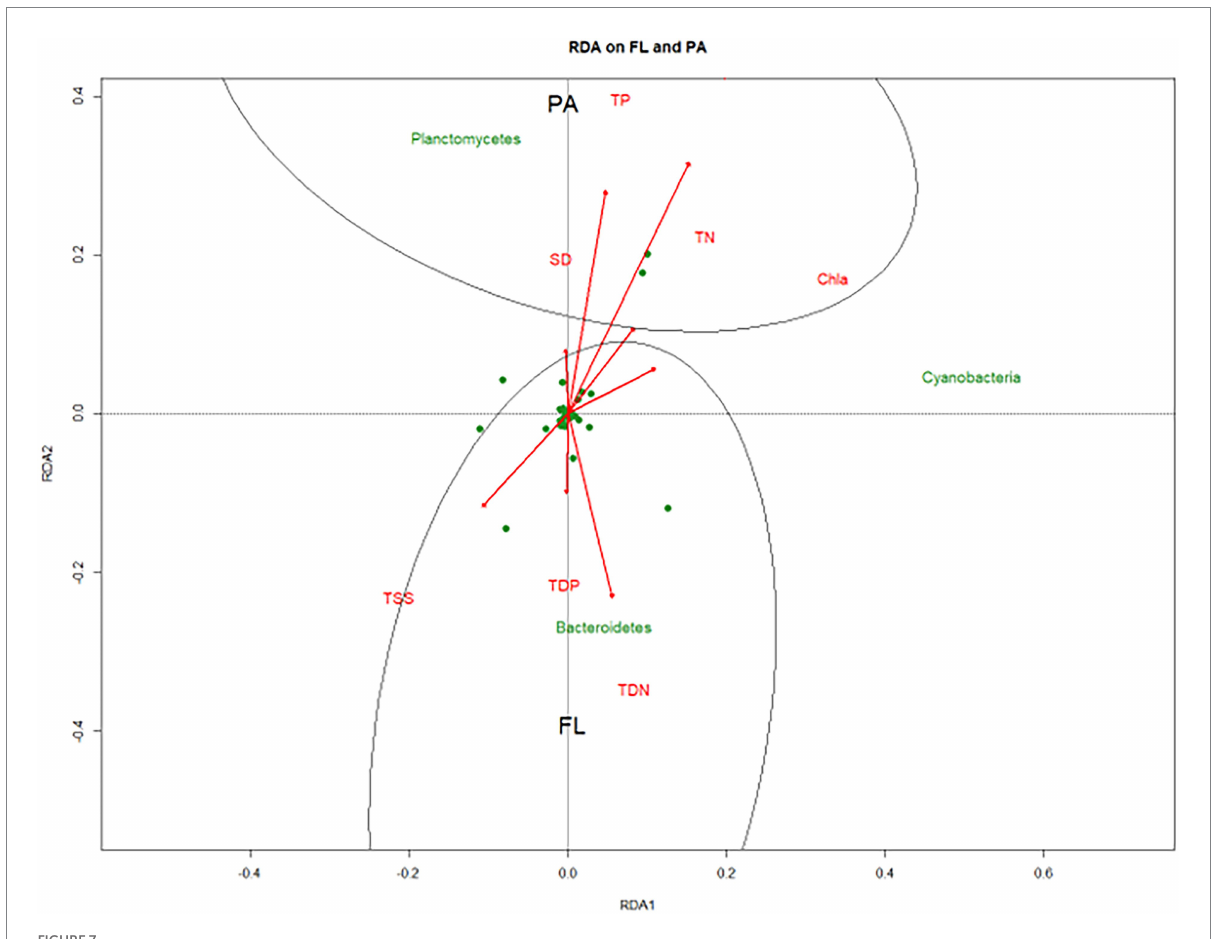
FIGURE 7 RDA plots of FL and PA bacterial community in Wujiangdu